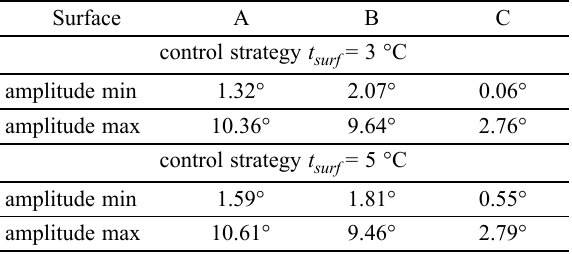
Table 3. Daily minimum and maximum amplitude of surface temperature fluctuations which occurred over the of investigated period Surface A B C control strategy t surf = 3 °C amplitude min